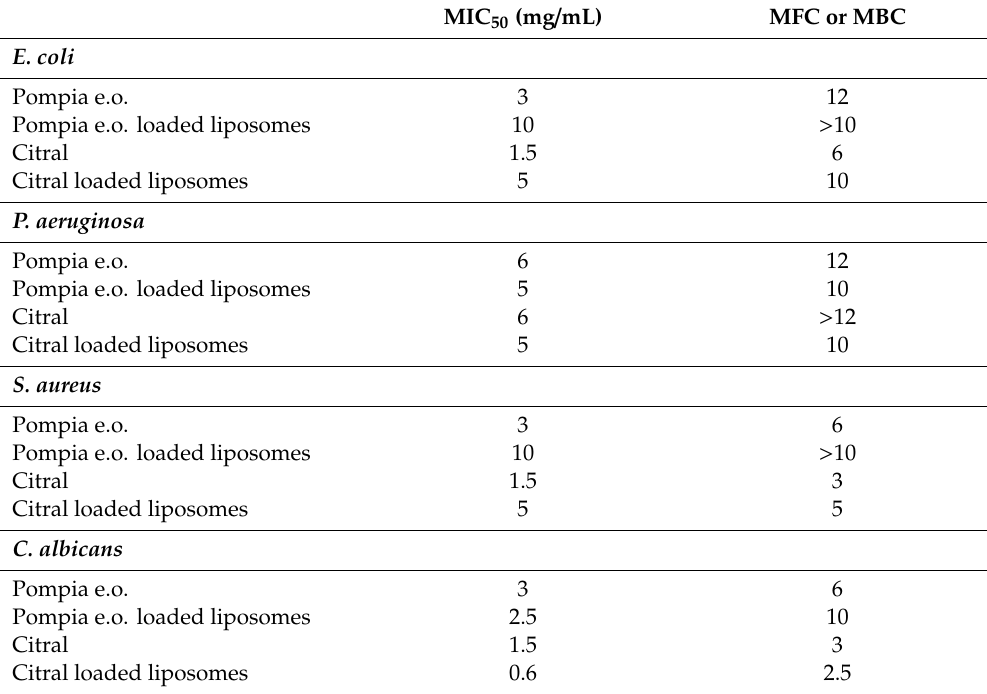
Table 4. Values of MIC 50 (minimum inhibitory concentration 50%) and MFC (minimum fungicidal concentration) or MBC (minimum bactericidal concentration) of pompia essential oil and citral in solution or loaded in liposomes. Results are expressed in mg of active ingredient per mL of final volume. MIC 50 (mg / mL) MFC or MBC E.